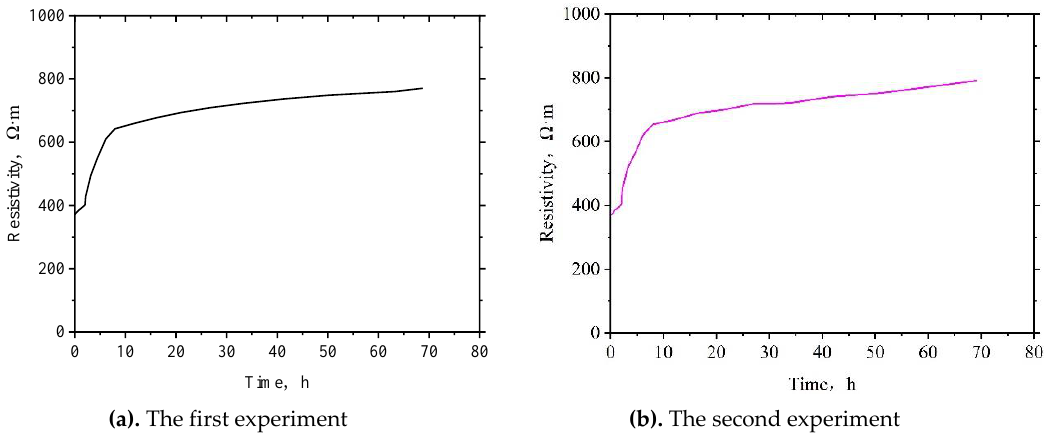
Figure 9. Resistivity changes during preparation of hydrate in spray method.